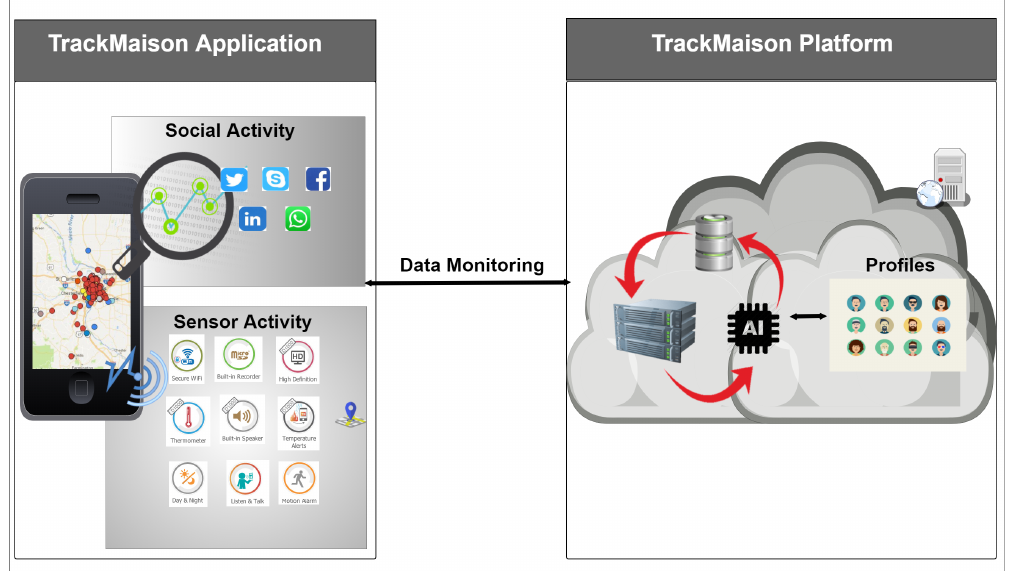
Figure 4. Machine intelligence module that uses the TrackMaison framework in